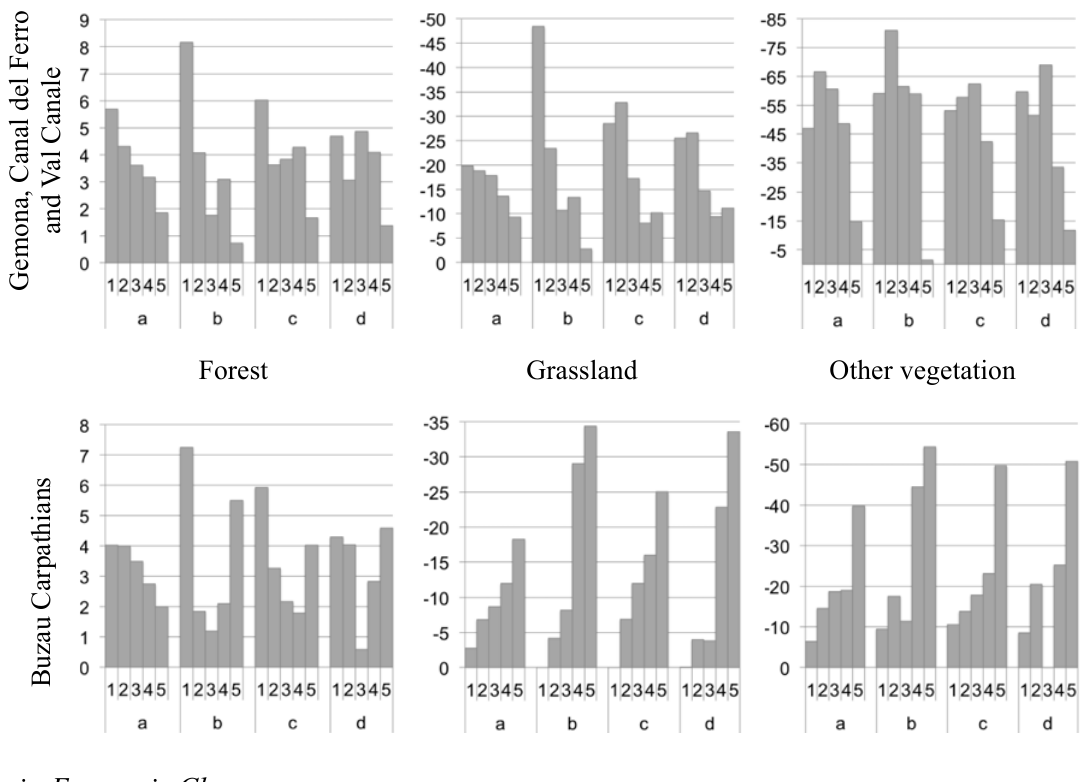
Figure 4. Summary of major land cover changes in quintile classes of slope ( a ), elevation ( b ) and distance to settlements ( c ) and roads ( d ). The charts present the percentage of forest, grassland and other vegetation classes that changed (increased or